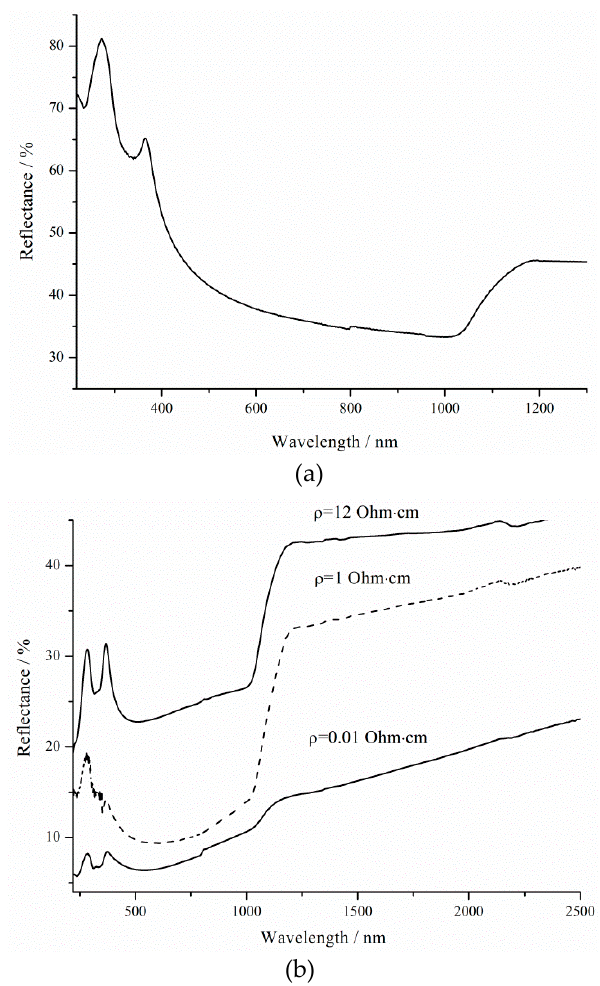
Figure 2. ( a ) Reflectance curve of the sample with ρ = 0.01 before treatment, and ( b ) reflectance curves of the samples with ρ = 0.01, 1, and 12 Ω ·cm after 10 min of treatment.